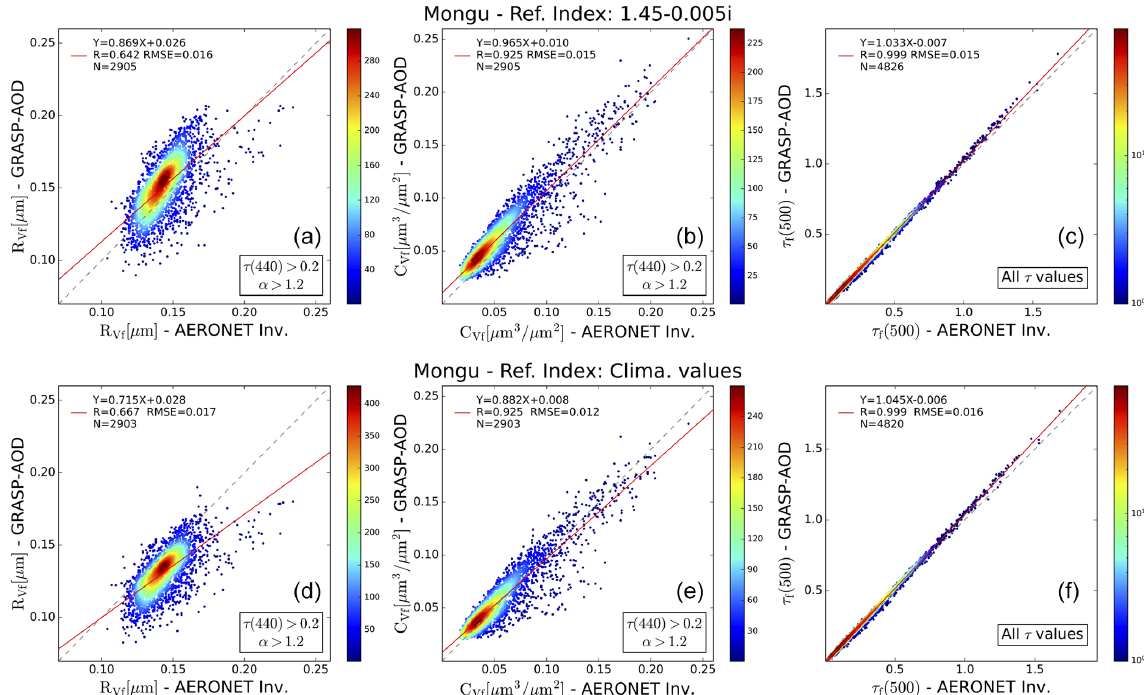
Figure 13. Comparisons between the fine-mode volume median radius ( R Vf [µm]; a, d ), the fine-mode volume concentration (C Vf [µm 3 /µm 2 ]; b, e ) and τ f ( 500 ) ( c, f ) obtained by the GRASP code and AERONET aerosol retrieval algorithm for the Mongu site during the whole analyzed period (measurements from 1997–2010 in the case of the Mongu site). In the retrievals in (a) – (c) , we have assumed standard values of the refractive index (1.45–0 . 005 i ) to run the GRASP-AOD. The retrievals in (d) – (f) correspond to the results of general analysis from Sect. 3 where monthly climatological values were used for the assumption of the refractive